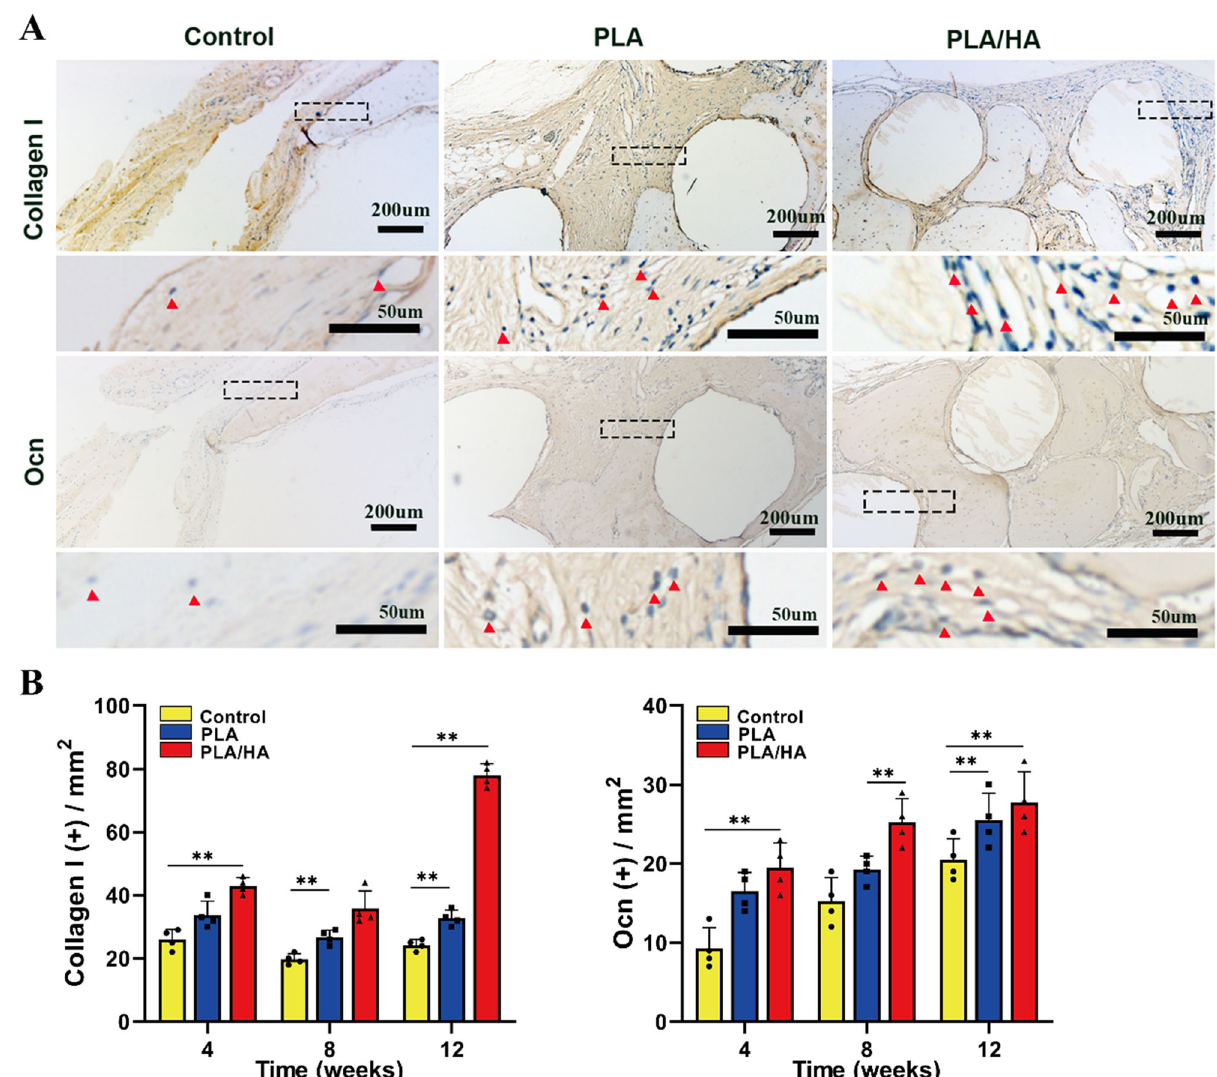
Fig. 9 Osteoblasts in bone defect area after treatment; A Immunohistochemical staining of Collagen I and OCN in the dif- ferent groups at 12 weeks. The black dotted boxes in the upper fi gures were enlarged in the lower fi gures. The red triangle indicates positively